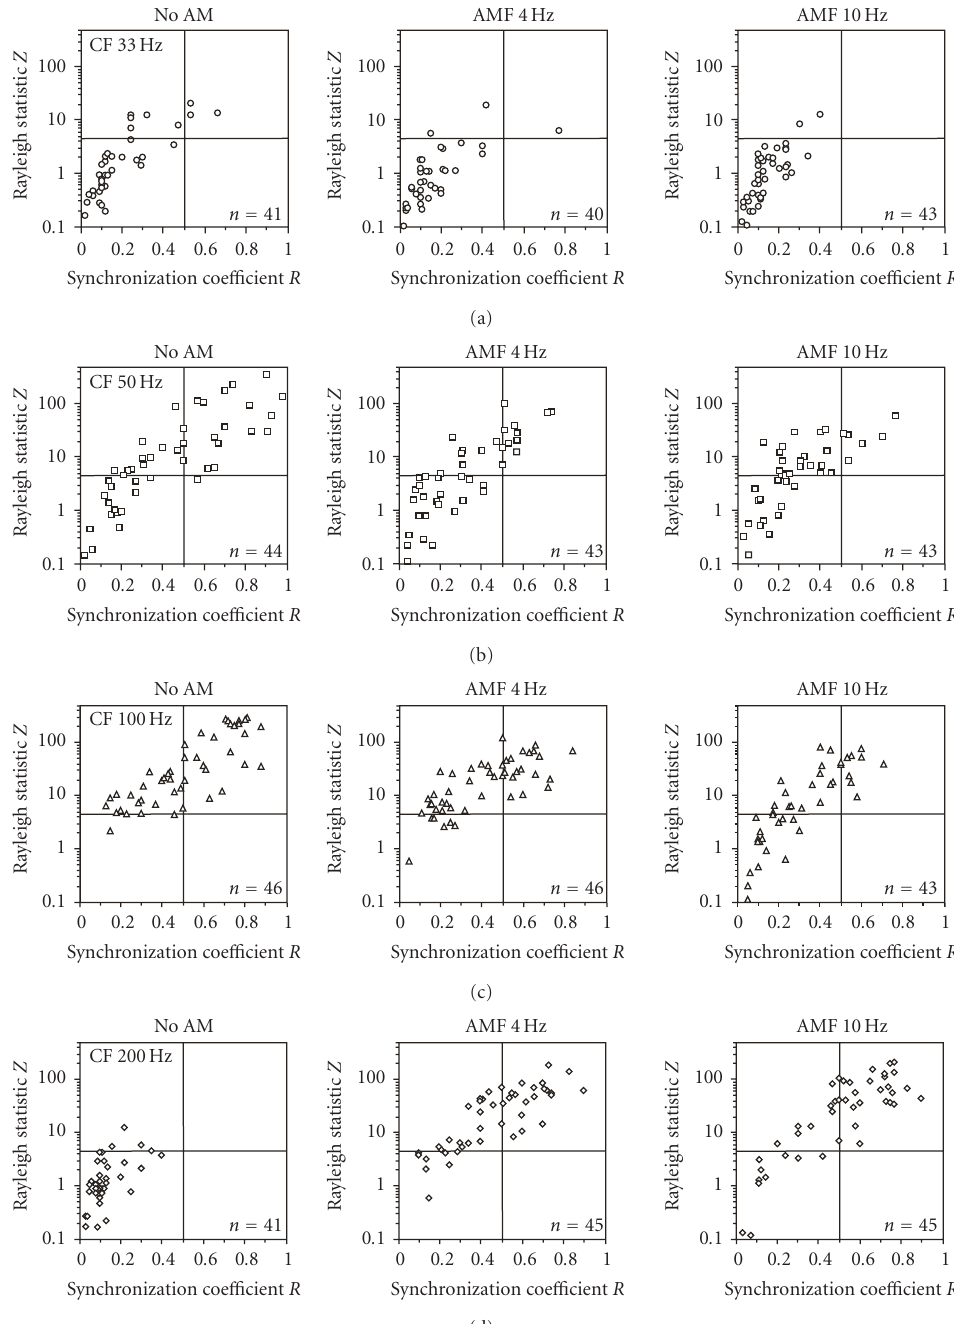
Figure 5: Phase coupling of MON units to constant-amplitude and to amplitude-modulated sine wave stimuli. Z values obtained from the Rayleigh test are plotted versus coe ffi cients of synchronization ( R ) with respect to the CF (left column) or with respect to the AMF (middle and right columns: 4Hz and 10 Hz, resp.). Horizontal lines, critical value of the Rayleigh test ( Z = 4.6). Vertical line, R = 0.5. See text for more